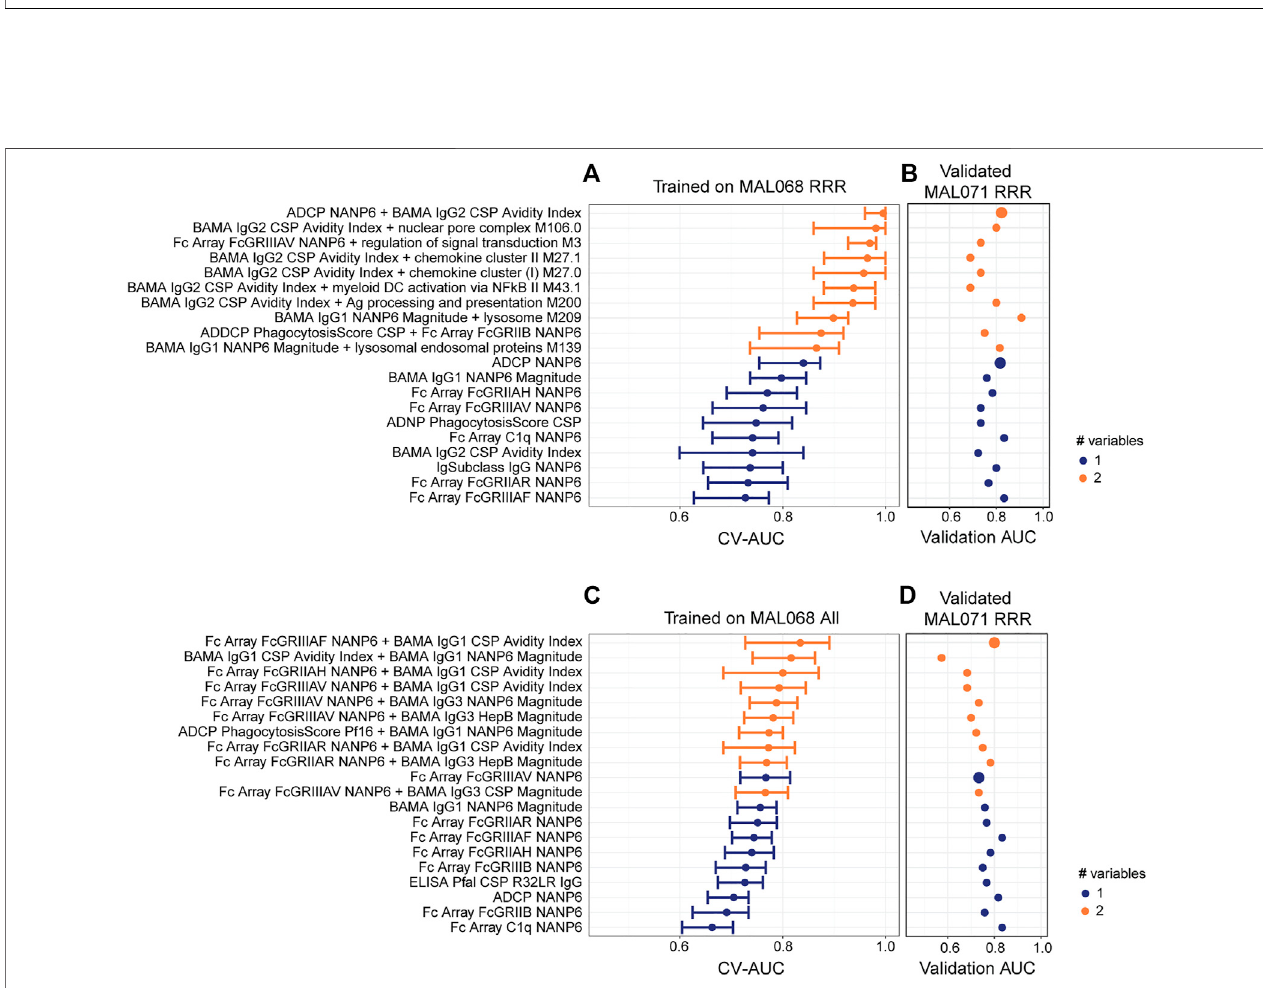
FIGURE 5 | Cross-study validation of univariate and 2-variate models. (A, C) Forest plots of cross-validated AUC scores for the top-performing univariate and 2- variatemodelstrainedon (A) theMAL068RRRdatasetor (C) theentireMAL068dataset.Alldatawereday-of-challenge.Dotsshowthecross-validatedAUCcalculated using the cvAUC package in R; whiskers extend through 95% empirical intervals of the 200 individual 5-fold cross-validation runs. (B, D) Validation AUCs of the same models as evaluated in predicting post-challenge outcomes in the RRR arm of MAL071. Purple, single-variable model; orange, two-variable model. The slightly enlarged bubbles in (B, D) identify the top-performing models as assessed by CV-AUC (A, C) .